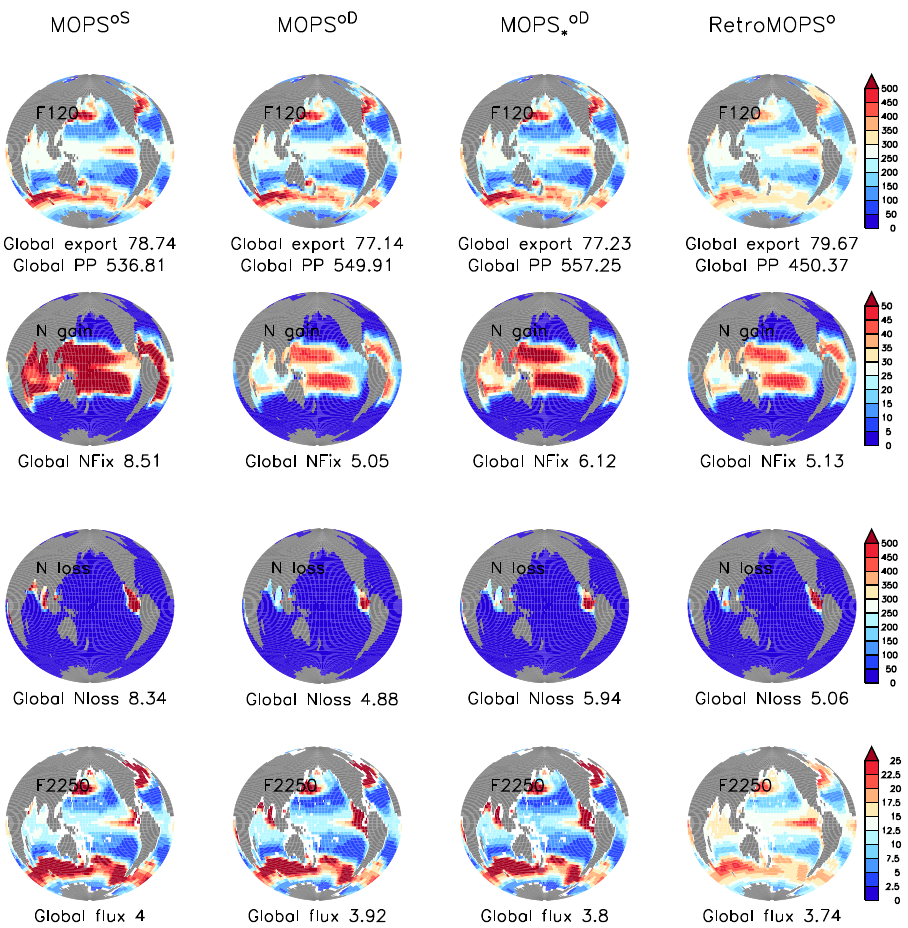
◦ S ◦ D ◦ D ◦ . Top: export production (here: sedimentation at 120m). , MOPS , MOPS ∗ and RetroMOPS